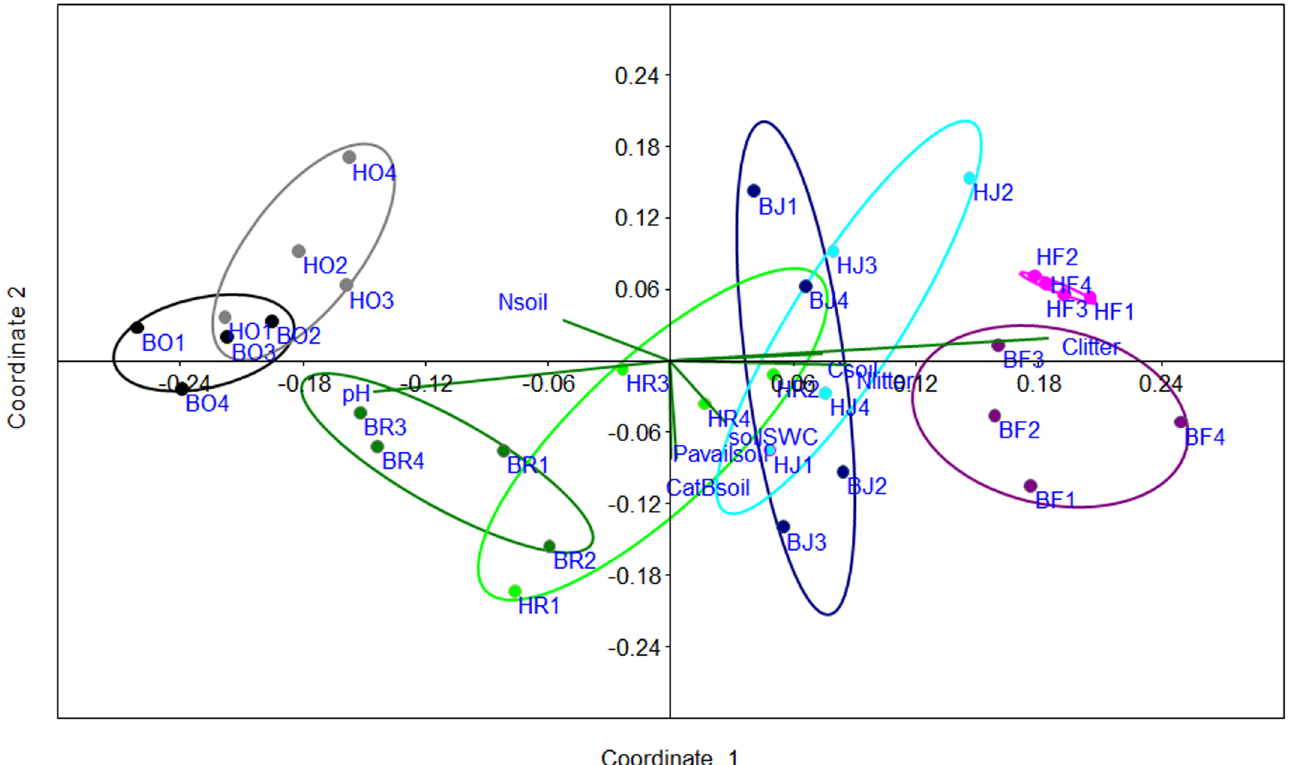
Fig 5. Non metric multidimensional scaling (NMDS) of root community-weighed traits. RCWTs with R > 0.5 and R < 0.5 from Table 1 for PC1 were used for NMDS. The following environmental parameters were plotted as explanatory variables: nitrogen and carbon concentrations in soil and litter (Nsoil, Csoil, Clitter, Nlitter), available phosphorus in soil (Pavailsoil), sum of basic cations in soil (CatBsoil), soil water content (soilSWC) and soil pH (pH). B = Bukit 12, H = Harapan, O = oil palm, R = rubber plantation, J = jungle rubber, F = forest. Stress: 0.106, R 2 for coordinate 1: 0.785 and for coordinate 2: 0.0735.